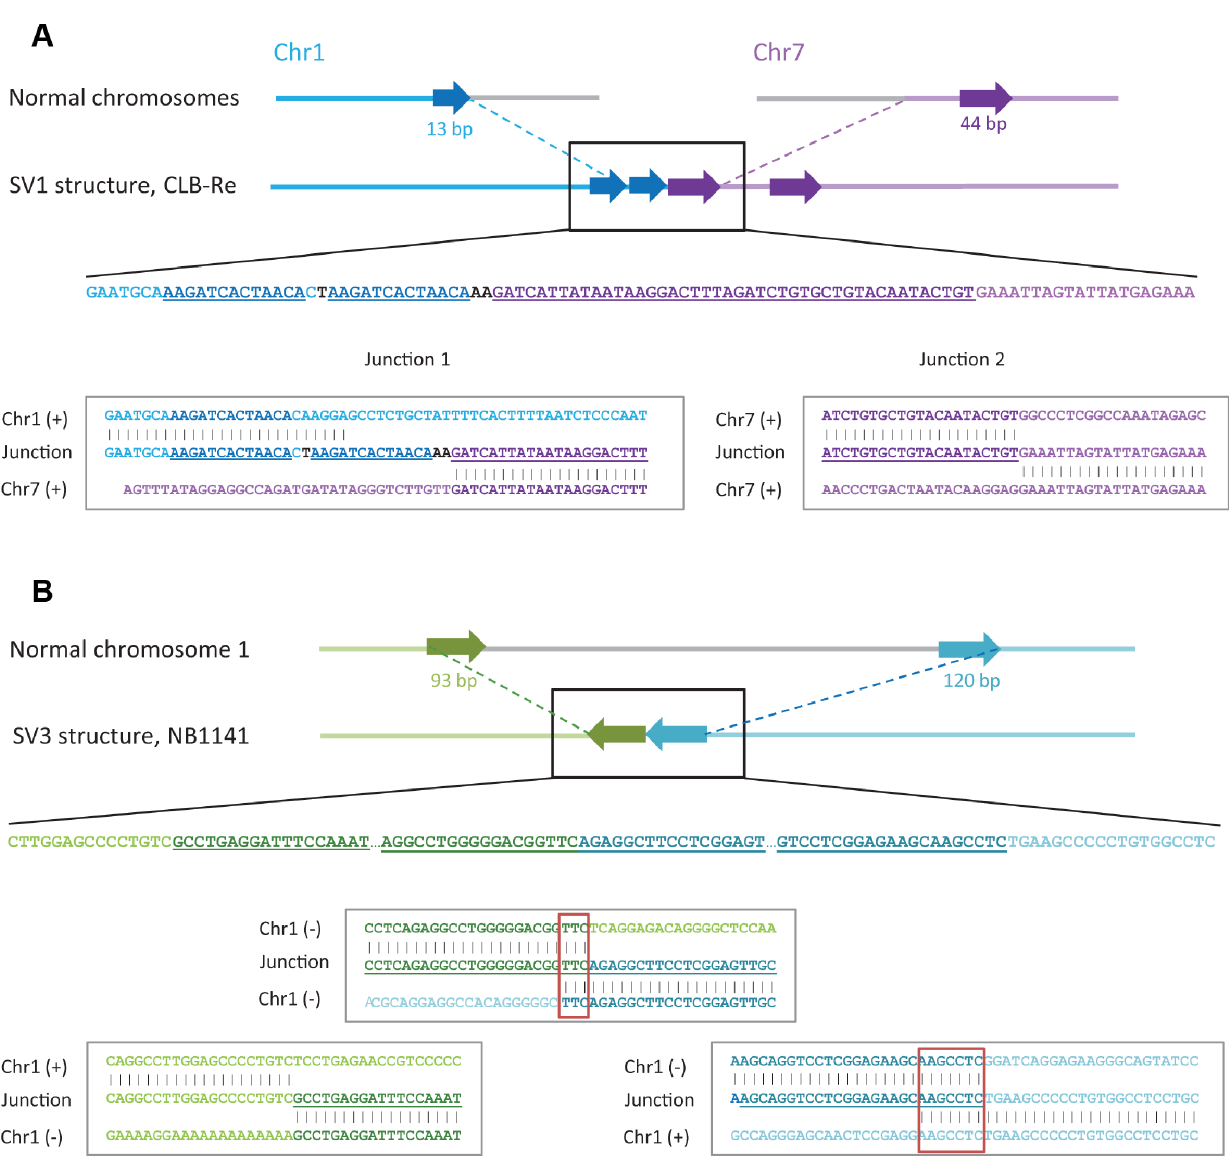
Figure 4. Examples of rearrangements with templated insertion of nearby sequences. A , Rearrangement SV1 between chromosomes 1 and 7 in CLB-Re; B , intra-chromosomal rearrangement SV3 on chromosome 1 in NB1141. In each panel, the top graph shows the schematic representation of normal chromosomes. Below is the schematic diagram of the SV. The nucleotide sequence of the rearrangement region (black box) is indicated below. Alignments in boxes illustrate the structure of each breakpoint within the rearrangement. Each partner in the rearrangement is shown by a different color. The parts of chromosomes that were lost during rearrangement are shown in grey. Regions that were duplicated ( A ) or inverted ( B ) are shown by arrows of a darker color in the diagram; corresponding sequences are underlined.